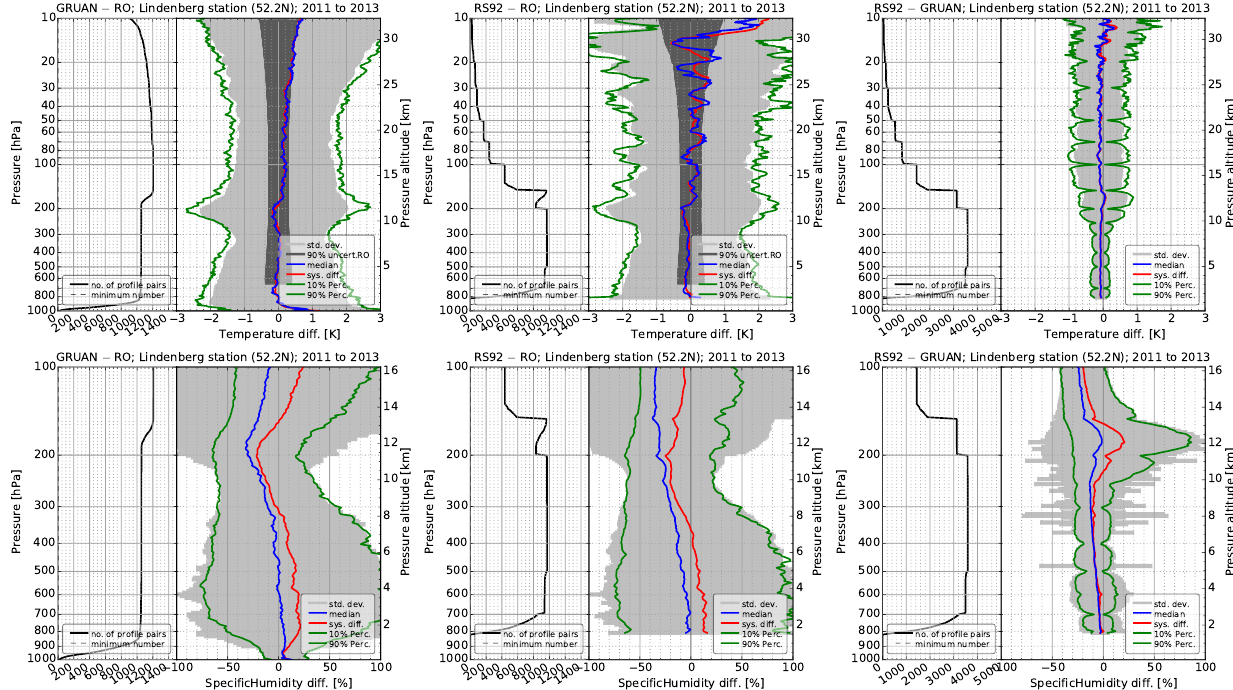
Figure 9. Same layout as Fig. 7, but for the GRUAN station in Lindenberg, Germany.